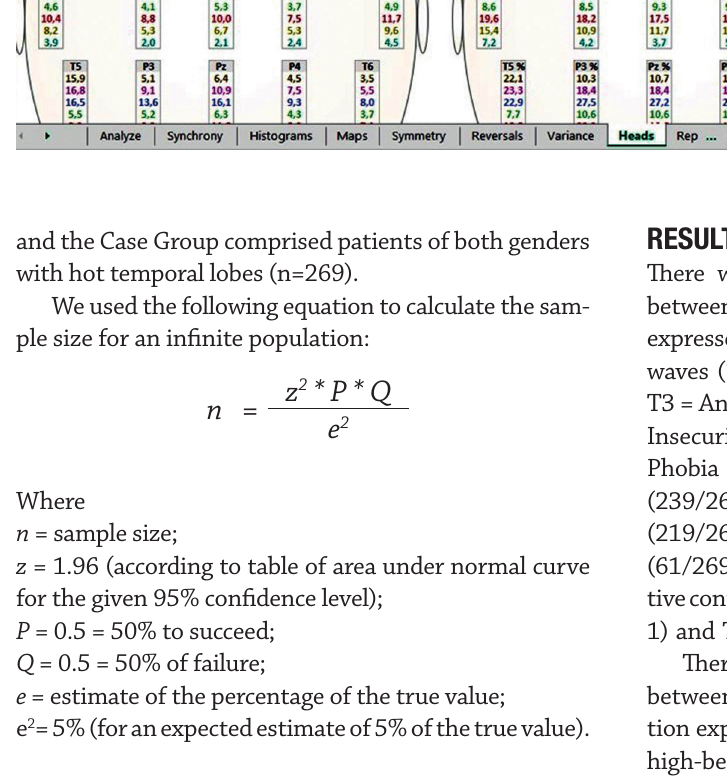
Figure 4. Percentage quantity above the expected beta wave (15-23 Hz >17%) and Beta-High (23-38 Hz >10%) at the T3 and T4 points of the 10-20 electroencephalography system in a broad statistical distribution (TQ-7 heads page), expressed in red color, representing the group studied (hot temporal